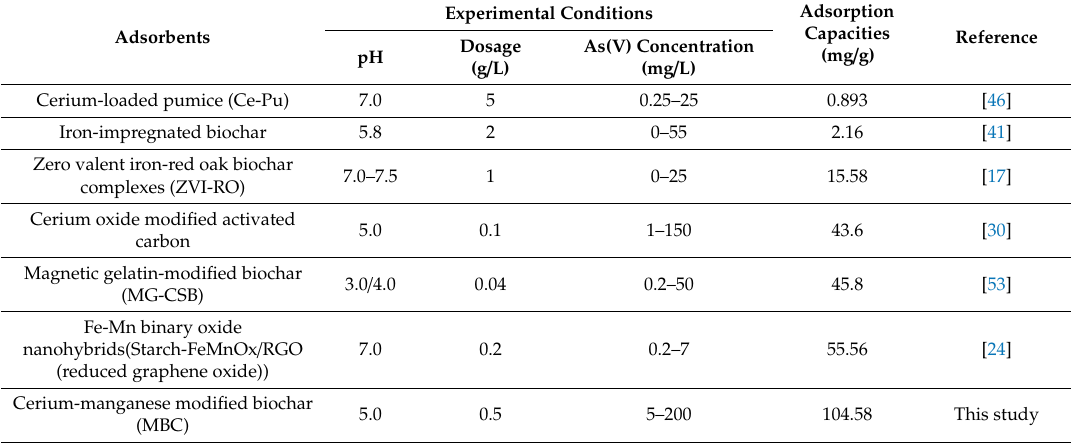
Table 3. Comparison of the As(V) adsorption capacity with some reported